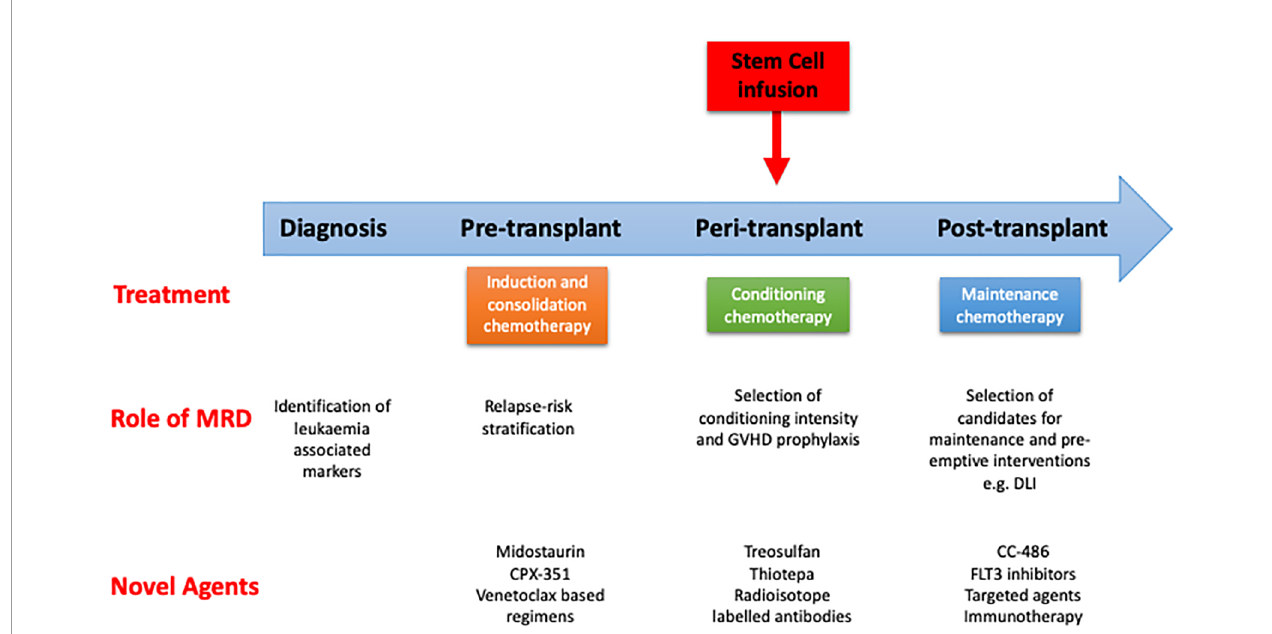
FIGURE 2 | Pathway of patient with AML undergoing curative treatment. Role of measurable residual disease (MRD) and novel agents at different stages. GVHD, graft vs host disease; DLI, donor lymphocyte